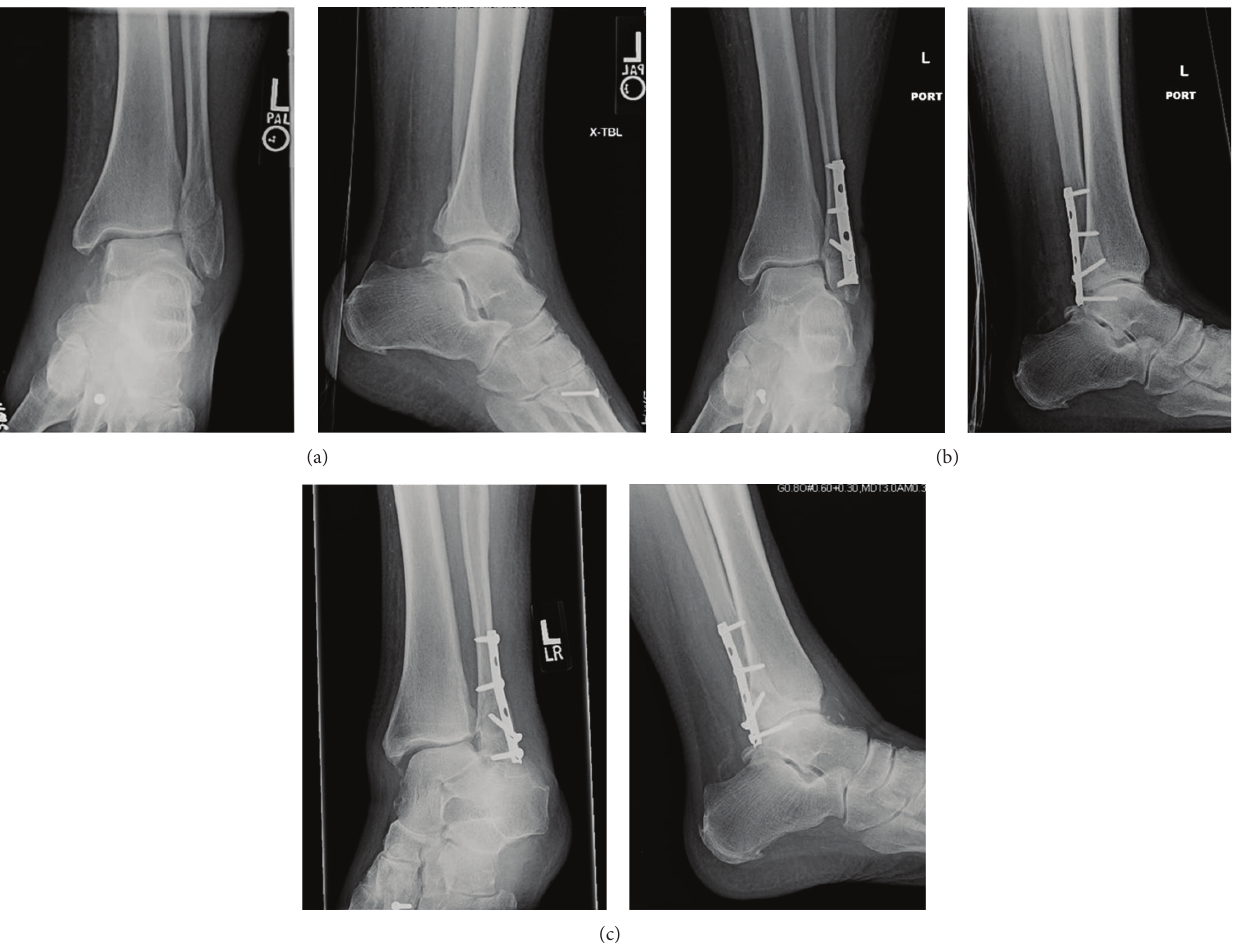
Figure 2: Single case of loss of reduction, suspect secondary to missed syndesmotic injury. (a) Preoperative mortise and lateral radiographs.